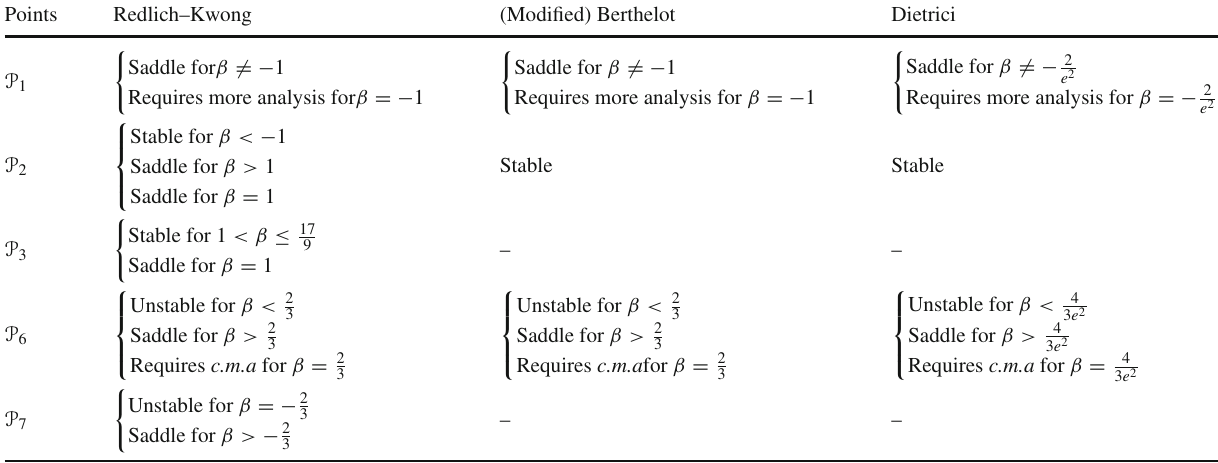
Table 3 Stability nature of the finite fixed points. When investigating the stability of a fixed point it is important to keep in mind the range of β for which the fixed point exists. The abbreviation c.m.a. stands for “ Center Manifold